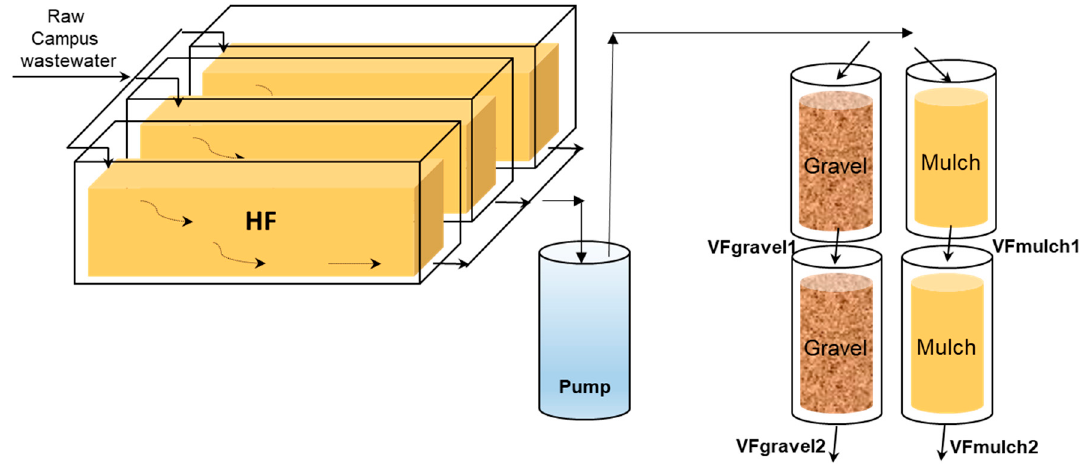
Figure 1. Layout of the hybrid CW: the mulch-based, horizontal flow (HF) and VFs with gravel (VFgravel) and mulch (VFmulch).